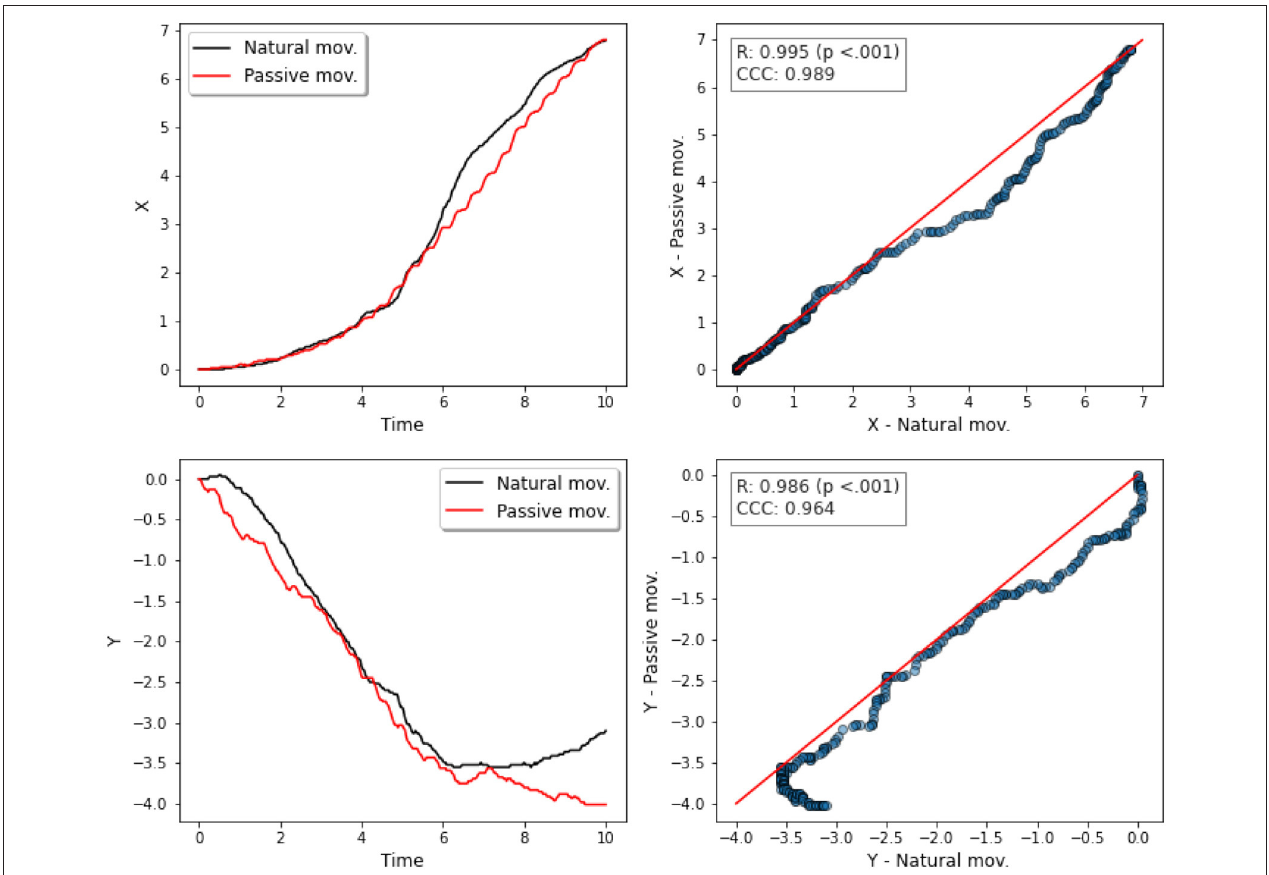
FIGURE 13 | Correlation analyses between x and y trajectories. First column: x and y trajectories vs. time for natural and passive movements. Second column: scatter plots with the 45 ◦ line (in red) to compare both movements—natural and passive—for x (top) and for y (bottom) trajectories.